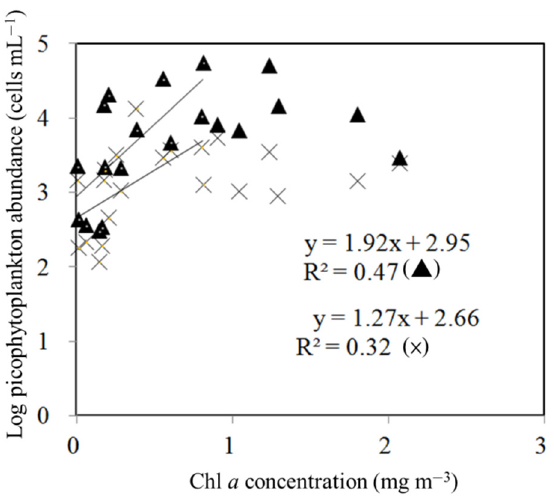
Figure 4. Relationship between Chl a concentrations and Synechococcus spp. ( ∆ ) and picoeukaryotic (×) abundance. The data points of the linear regressions were below 1 mg m − 3 of Chl a concentration.